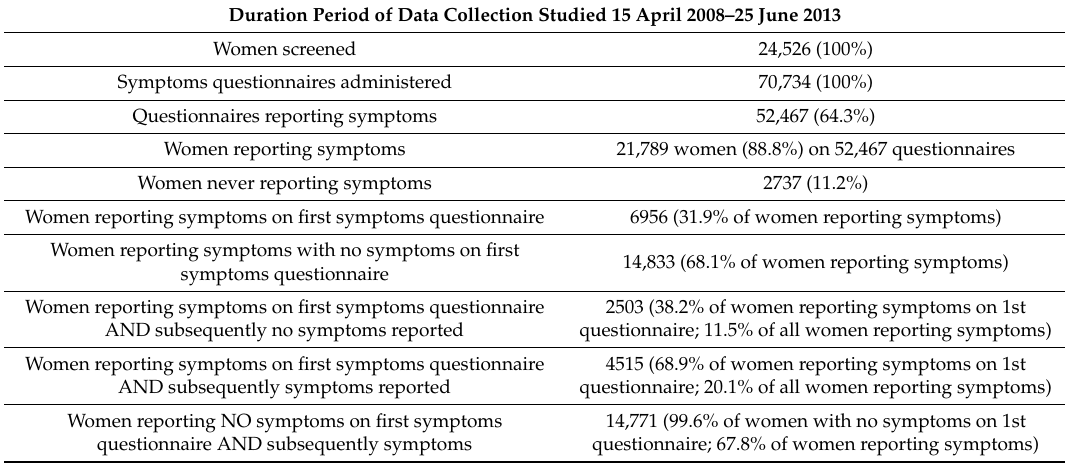
Table 2. Frequency and occurrence of symptoms.